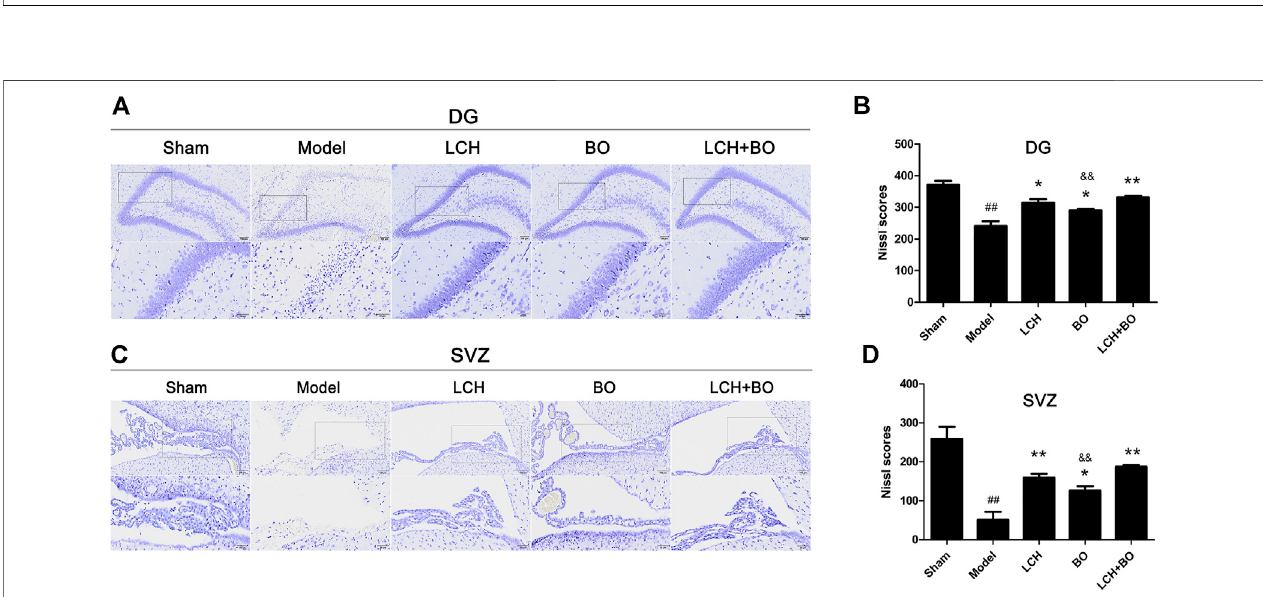
FIGURE 1 | Neurological severity scores and cerebral infarction rate of MCAO rats. (A) The results of neurological severity scores ( n (cid:1) 10). (B) Representative pictures of TTC staining. (C) The results of cerebral infarction ratio ( n (cid:1) 6). ## p < 0.01 compared to the sham group; * p < 0.05, ** p < 0.01 compared to the model group; & p < 0.05, && p < 0.01 compared to the LCH + BO group.